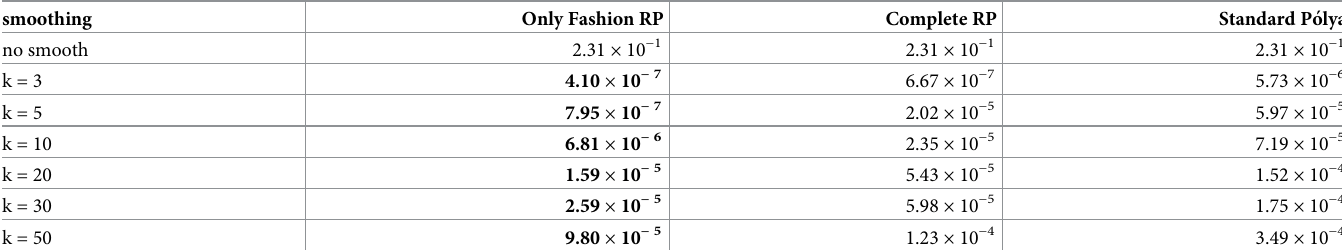
Table 10. “10 days traffic” ( T = 0.35, only BOTs’ posts, D = 30 00 , S = 100 slots of equal size): MSE for different levels of smoothing. smoothing